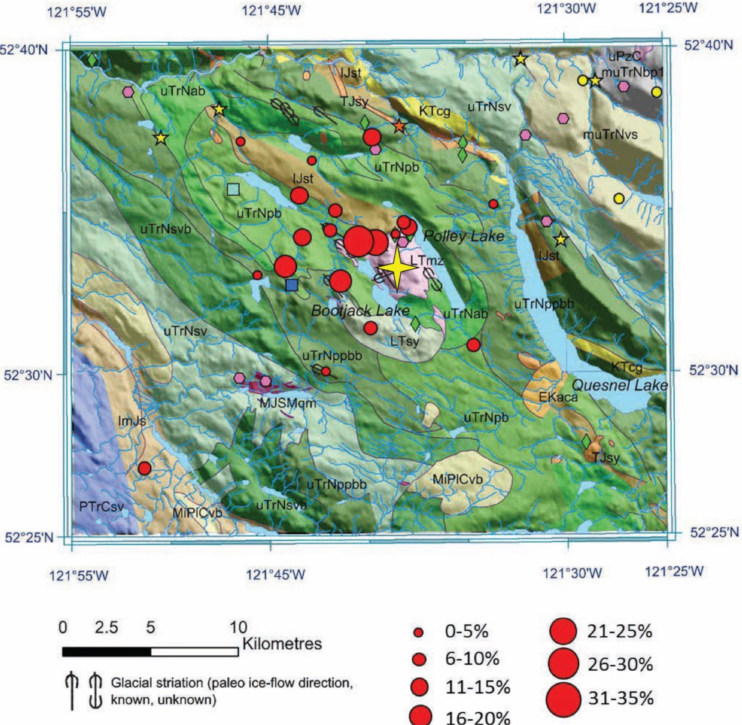
Figure 14. Percentage of magnetite grains that were identified as ‘hydrothermal porphyry’ based on the Ti-Ni/Cr discrimination diagram of Dare et al. (2014) [118] in 20 till samples around the Mount Polley Cu-Au deposit. Symbol size is proportional to percentage of total number of magnetite grain analyzed. Deposit location indicated by yellow star. Bedrock geology from Logan et al. (2010) and Plouffe and Ferbey (2017) [58]. Modified from Pisiak et al. (2017)